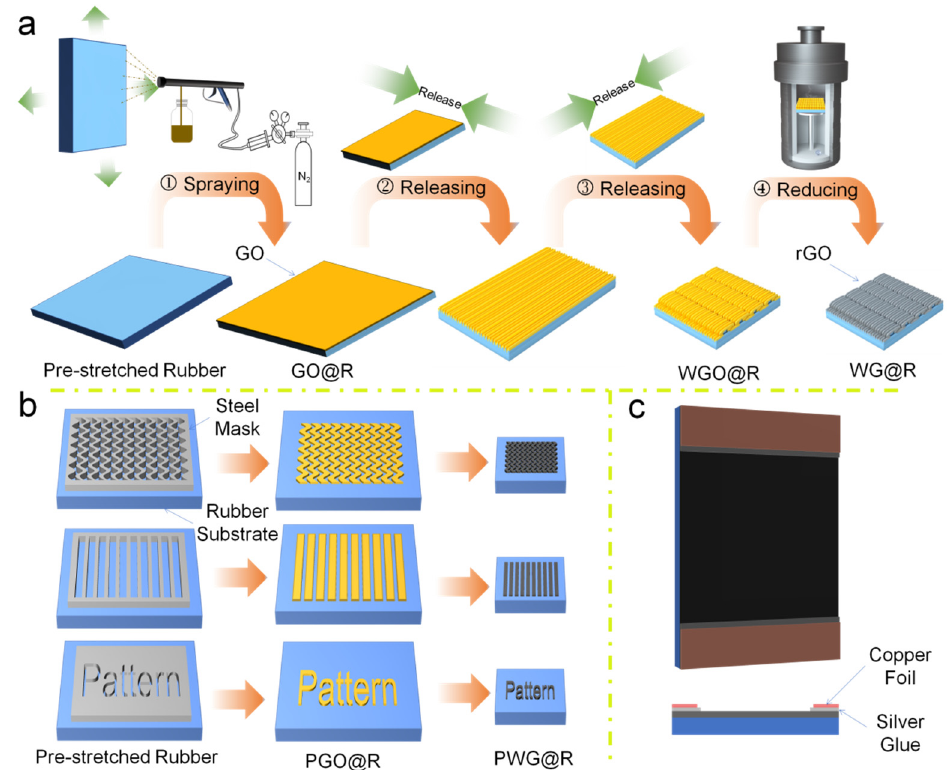
Figure 1. The schematic illustration of the fabrication process. ( a ) Fabrications of WG@R, ( b ) patterning of various PWG@Rs, and ( c ) the assembly of the PWG@R-based strain sensor.